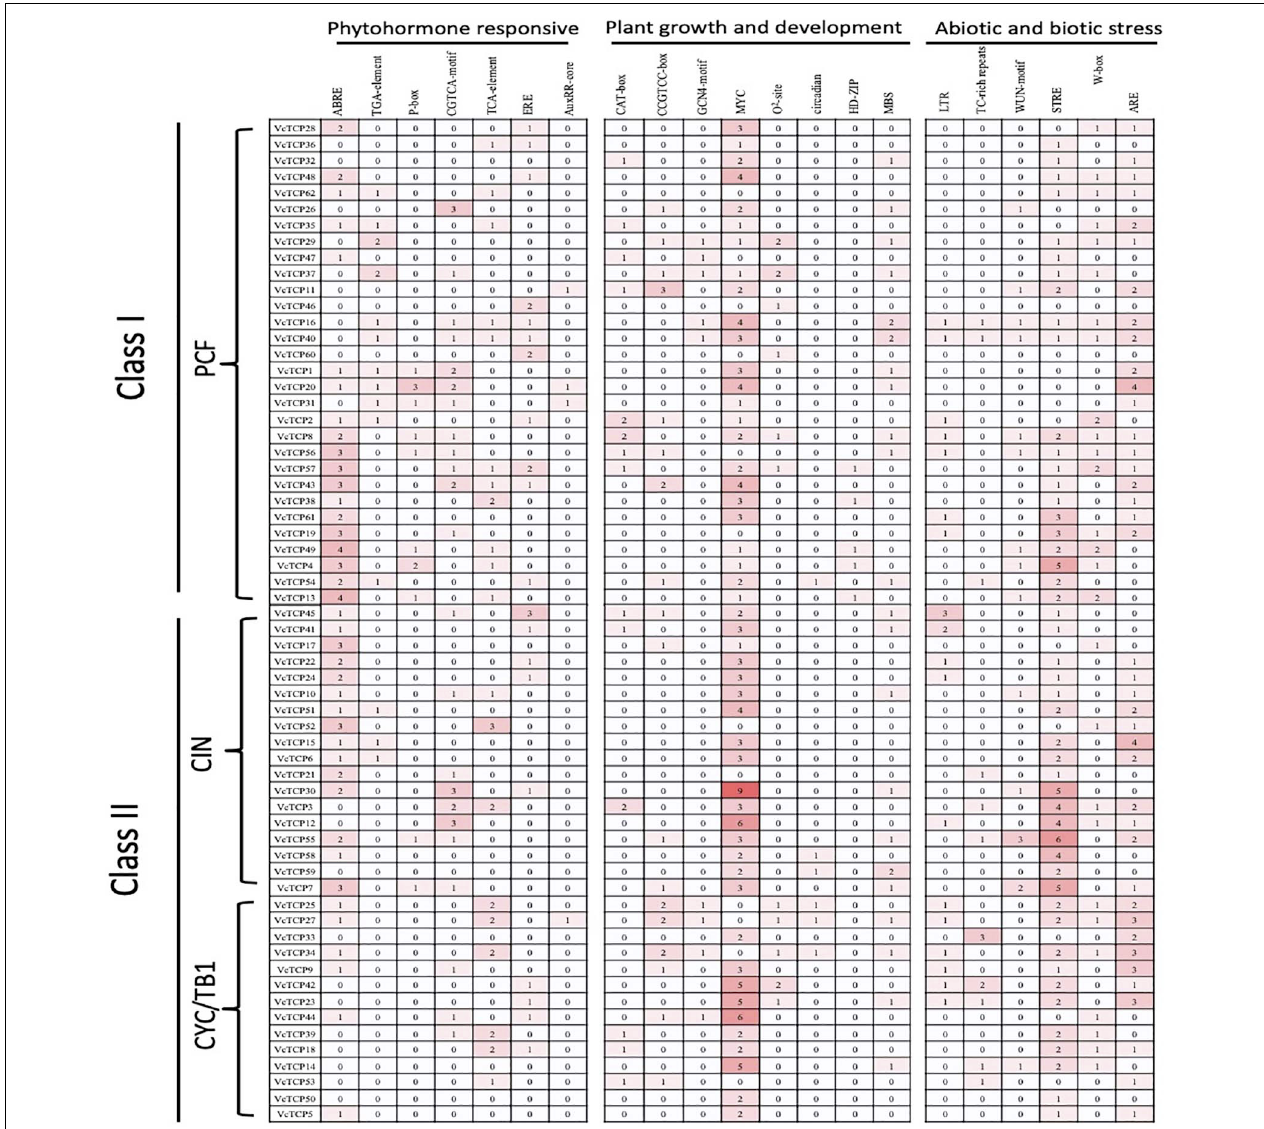
FIGURE 4 | Cis- regulatory elements analysis of the promoter region of VcTCP genes. Numbers of each cis- regulatory element in the promoter region of VcTCP genes. Based on the functional annotation, the cis- acting elements were classified into three major classes: phytohormone responsive, plant growth and development, and abiotic and biotic